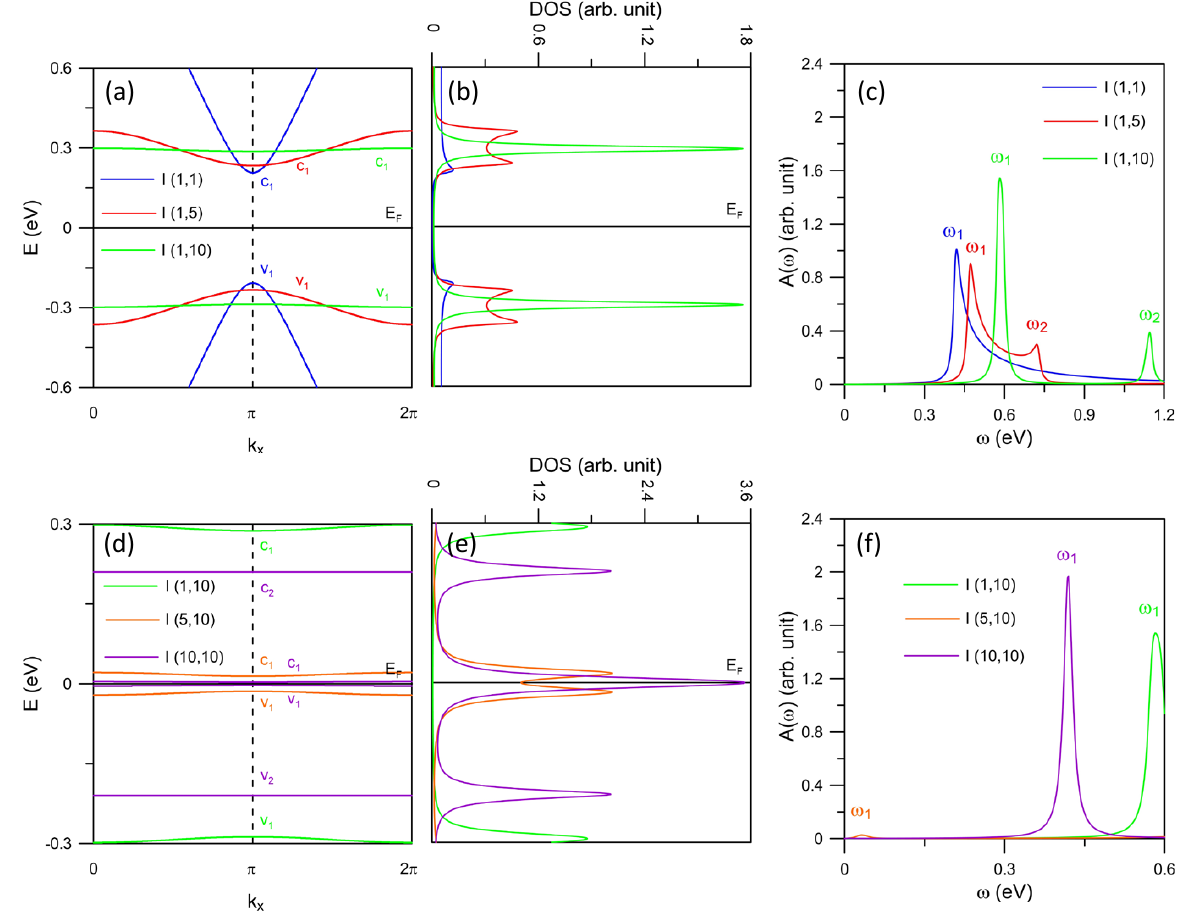
Figure 4. (color online) ( a ) Band structure of I- ( n , m ) AGNRs with n = 1 and various m ’s. ( b ) The corresponding DOS and ( c ) absorption spectra for Γ = 10 meV. Panels ( d – f ) present similar plots for m = 10 and various n